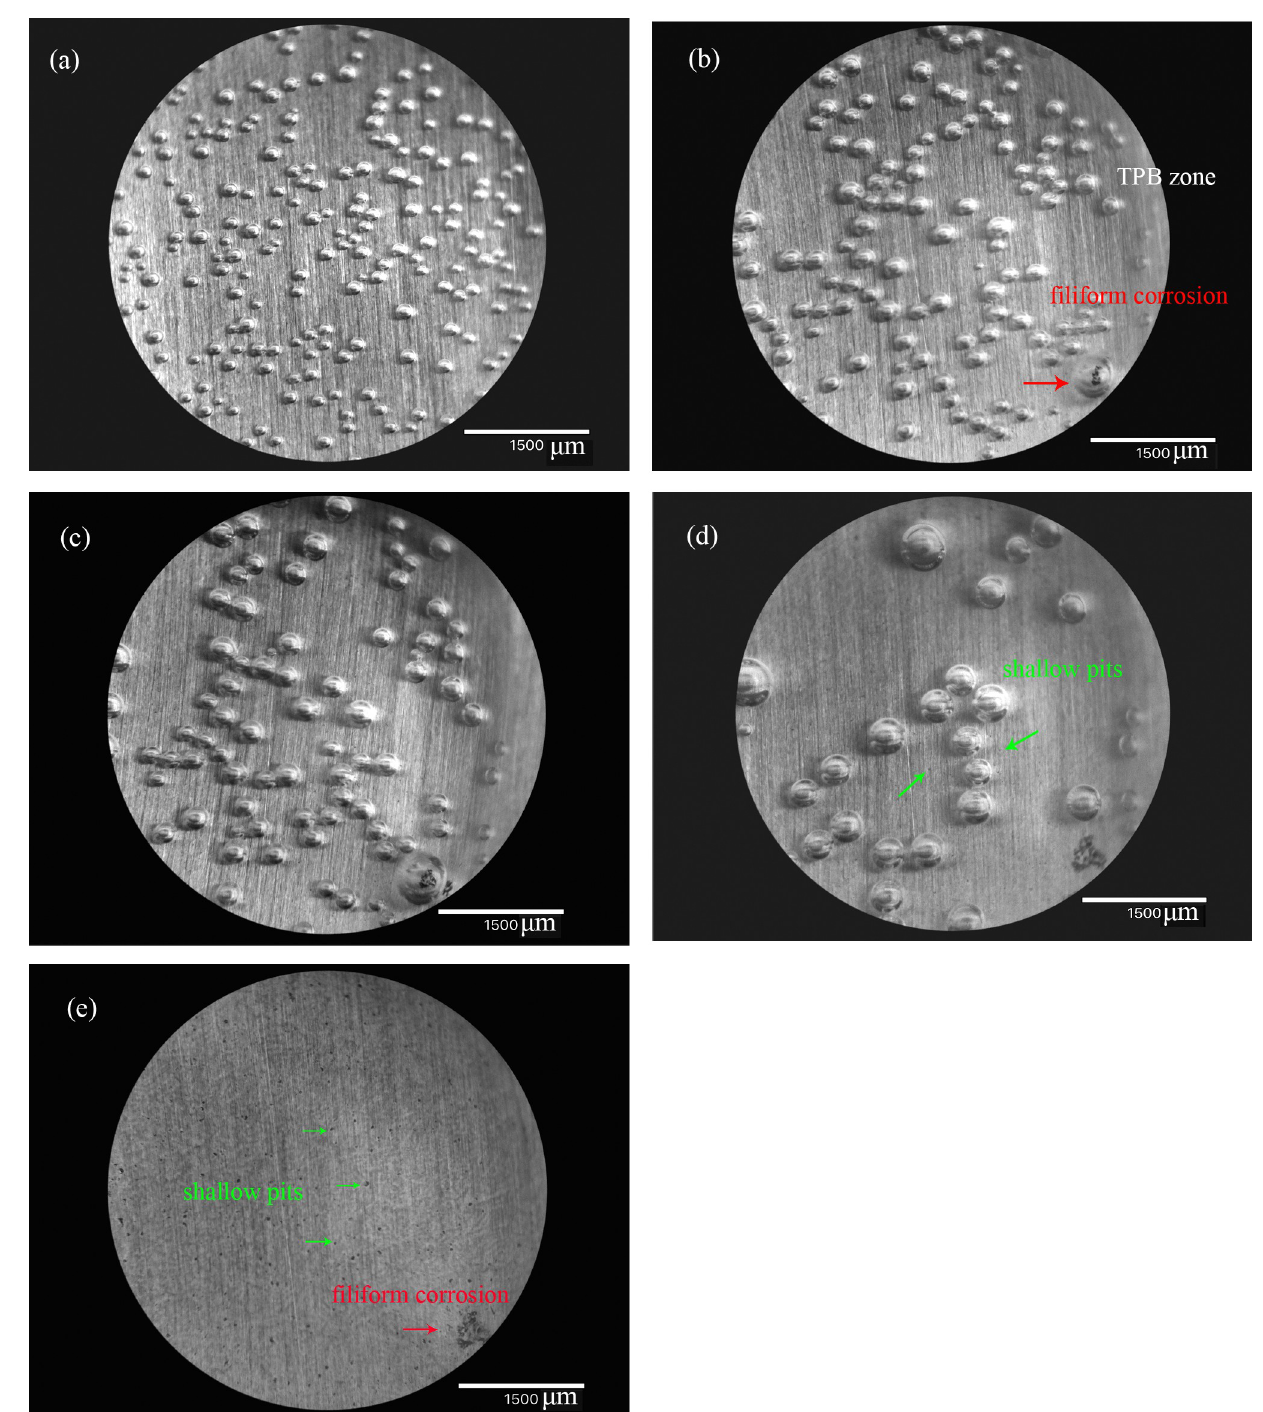
Fig 7. Optical images of AZ91D alloy under TEL after different time. a: 5min, b: 3 h, c: 6 h, d: 10 h.